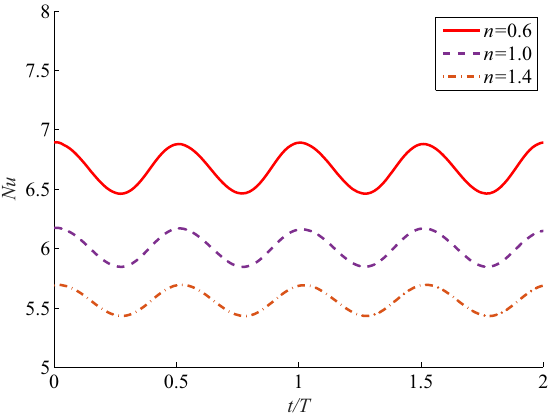
Figure 9. Time histories of the averaged Nusselt number for Re = 100, Pr = 1.0, and H ∗ =